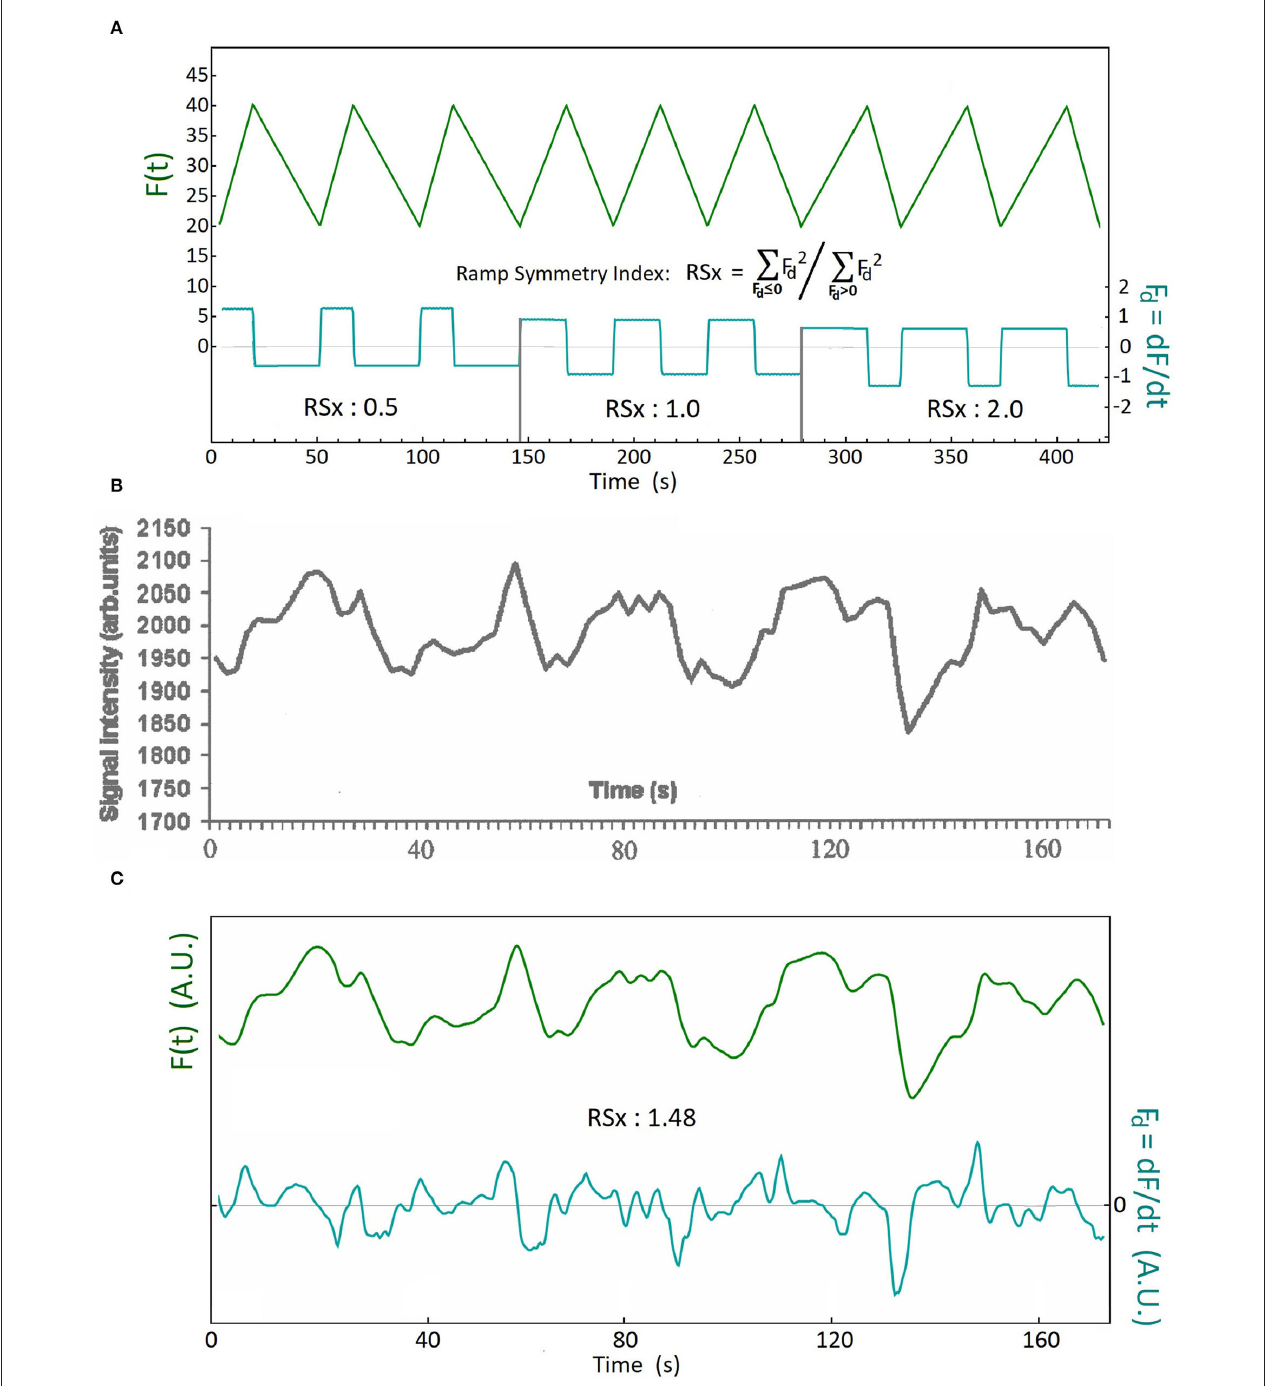
FIGURE 1 | The definition of the Ramp Symmetry Index (RSx), and an illustrative example using analysis of a CBF slow wave. (A) Upper tracing: F(t) is a ramp function with three different rates of descent and ascent. This is manifest in the time derivative F d (t) of the function (lower tracing). The time derivative time series is used to calculate the ramp symmetry index RSx. It is defined as the ratio of the sum of all squared samples with a negative sign (before squaring) divided by the sum of all squared samples having a positive sign. (see methods for formula); (B) An example of a continuously displayed blood oxygen level dependent (BOLD) MRI signal sequence, reflecting CBF slow oscillations, as reported by Kiviniemi et al. (20) (reproduced with permission); (C) The upper tracing ( green ) is the digitized and low-pass filtered tracing of the published BOLD signal in (B) . The lower tracing ( cyan ) is the time derivative of the upper. The ramp symmetry index of the sequence is calculated using the formula in (A) . An RSx of 1.48 means that the rate of decent is on average higher than the rate of ascent in this example. A plateau shaped wave is demonstrated by the third wave at the 80 second mark, and a double peaked wave is demonstrated by the fifth wave, at the 160 second mark [tracing (B) , and upper tracing in (C)